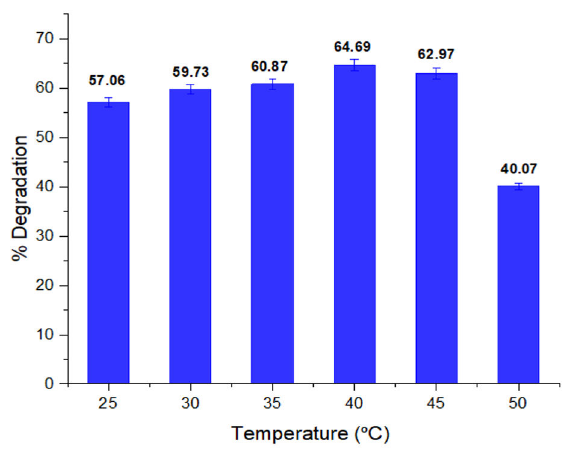
Figure 4. Temperature impact on % degradation of methyl red